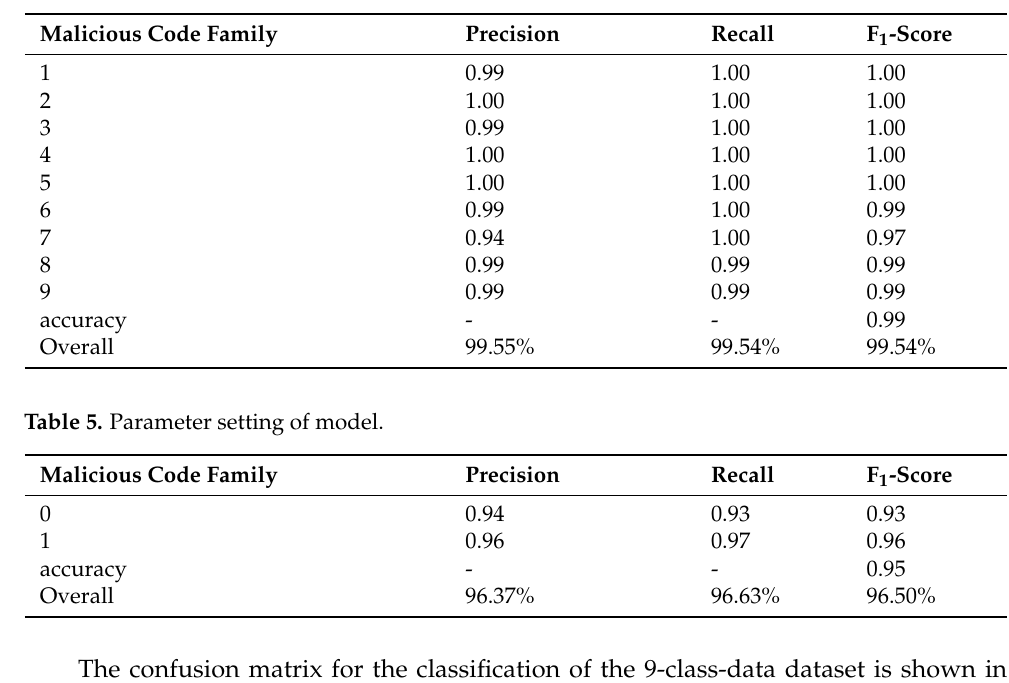
Table 4. Parameter setting of model.